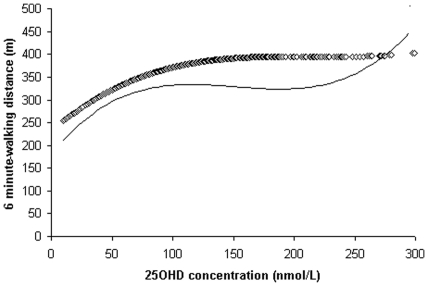
Loess regression plots of 6-minute walking distance (meters) by 25-hydroxyvitamin D (25OHD) concentrations; straight line–for women and diamond line ◊◊ for men.